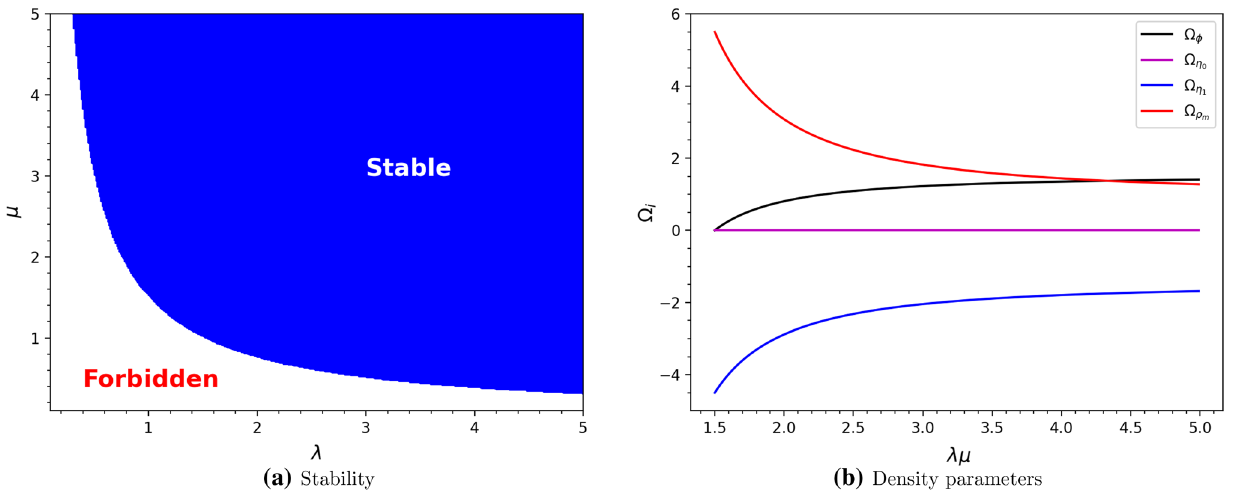
of non-vanishing fields and free parameters, i.e., λ and μ . The black, 1 purple, blue and red line in graph b indicates (cid:12) φ , (cid:12) η respectively